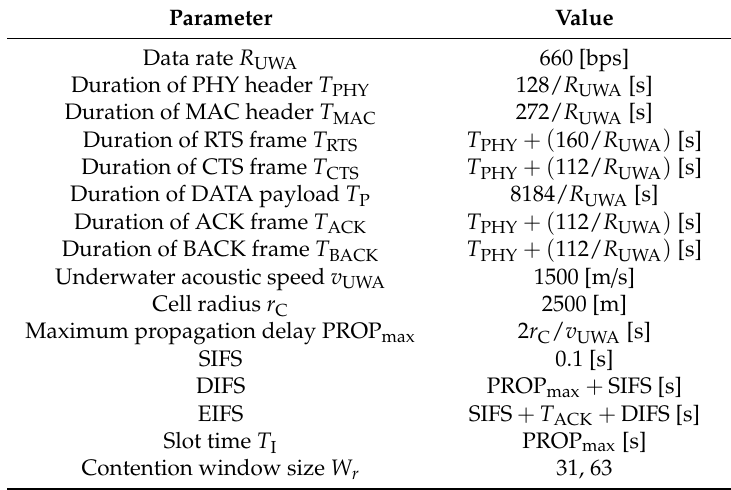
Table 1. Input parameters and values for analytical and simulation results.